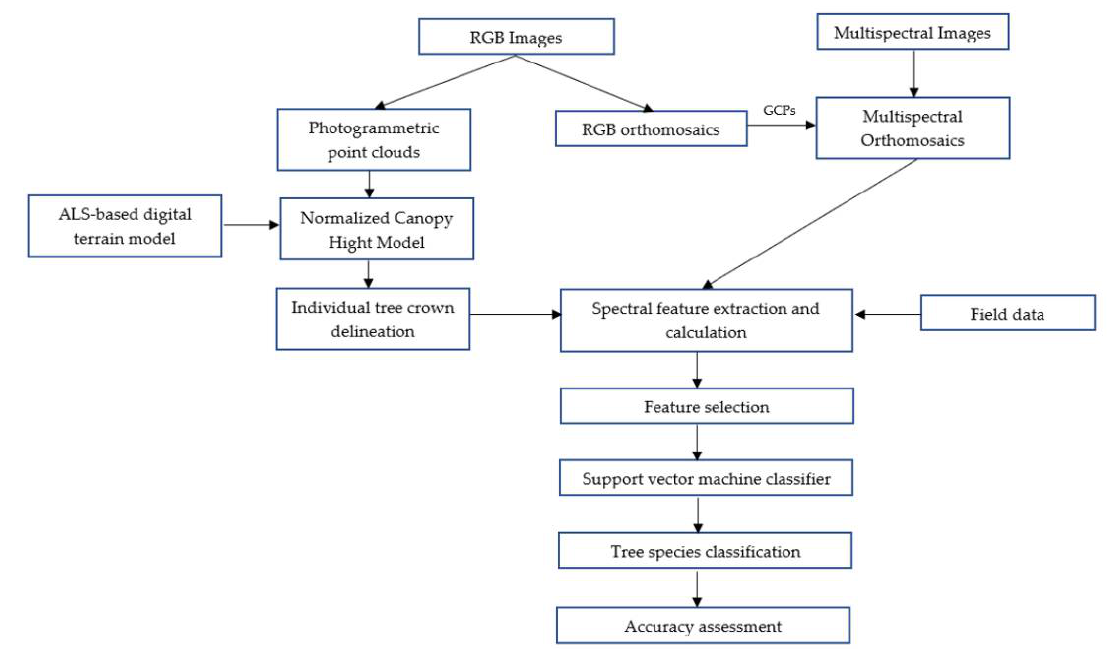
Figure 1. The analysis workflow of the study. Most of the field data were collected simultaneously with the flight campaign in July 2018. Separate field datasets were collected for study areas covered by MicaSense and Sequoia sensors (see chapter 2.2). Field measurements of the main tree species were conducted from 25 circular 9-m radius sample plots situated in semiclosed and fully closed canopy forests. Within each sample plot, tree species, diameter at breast height (DBH), tree height, and tree positions were recorded for all trees with DBH > 45 mm. In order to ensure the crown visibility from the UAV images and to better capture the mature and old-growth aspens, only the living and standing trees with DBH over 200 mm were selected for the analyses. The sparse and clustered occurrence of aspen in the study area led